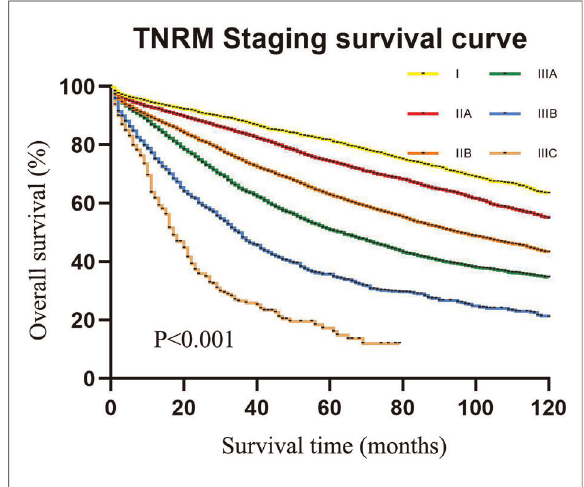
FIGURE 4 The 5-year survival rate of CRC patients in the training set using CRC patients from the SEER database according to TNRM